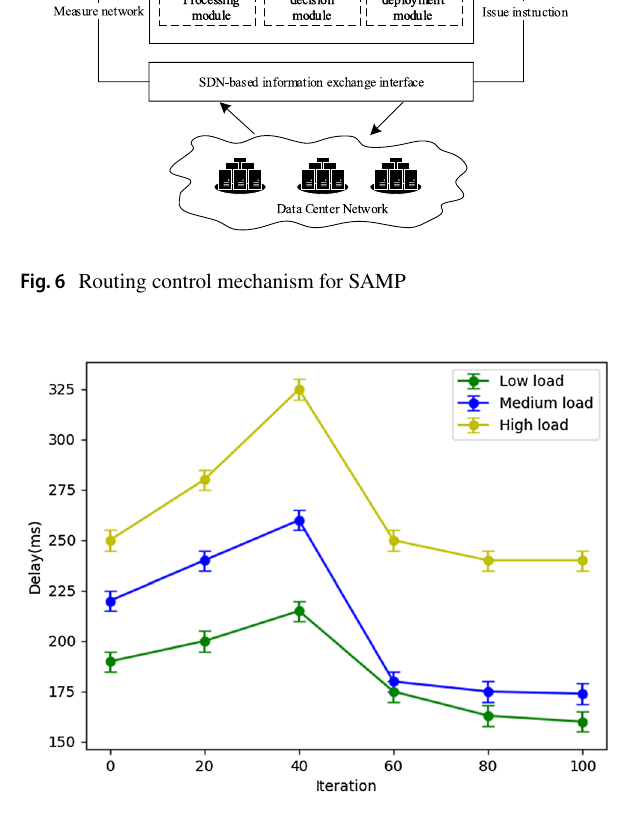
Fig. 7 Schematic diagram of algorithm